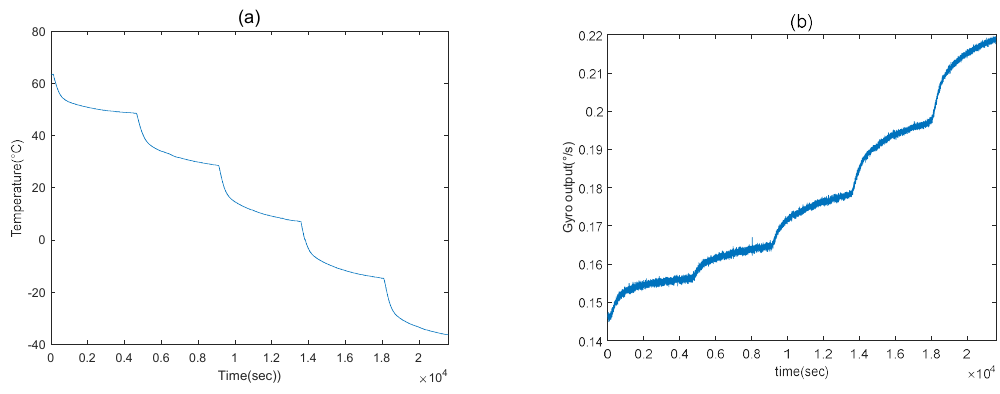
Figure 7. The results of temperature experiments.